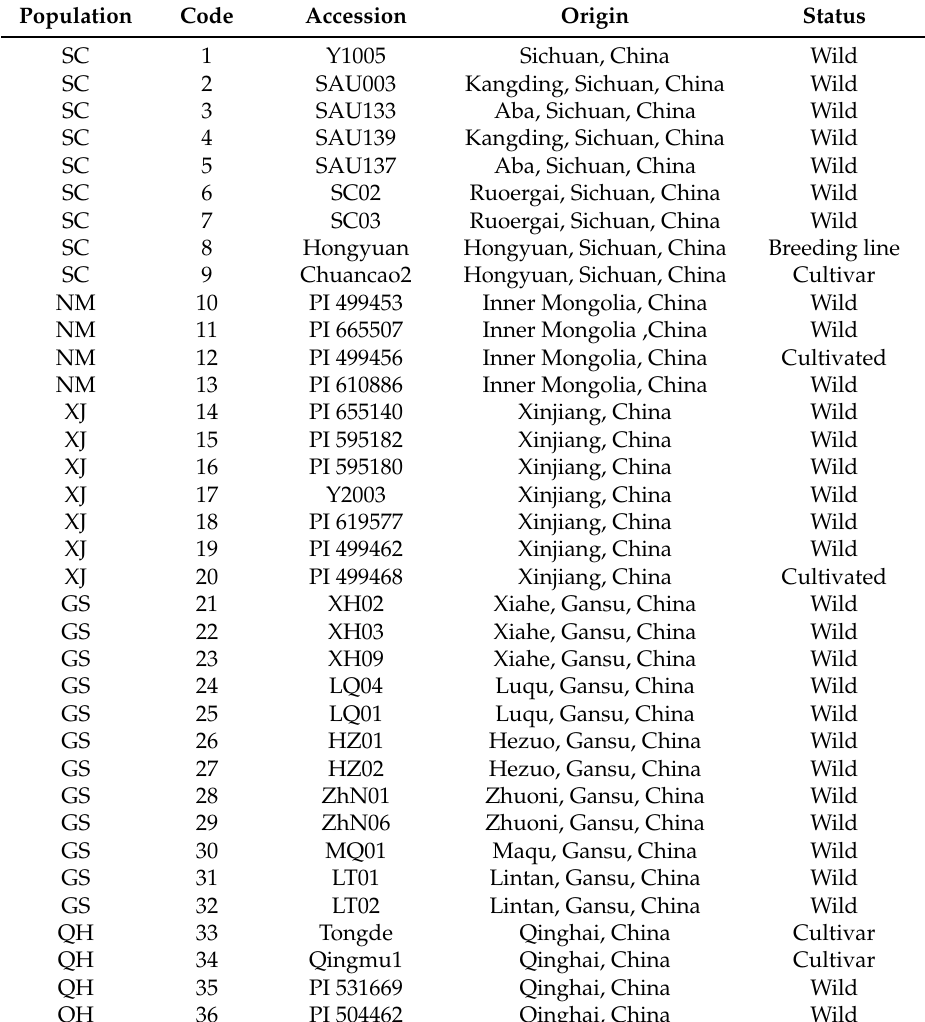
Table 1. E. sibiricus accessions used in the